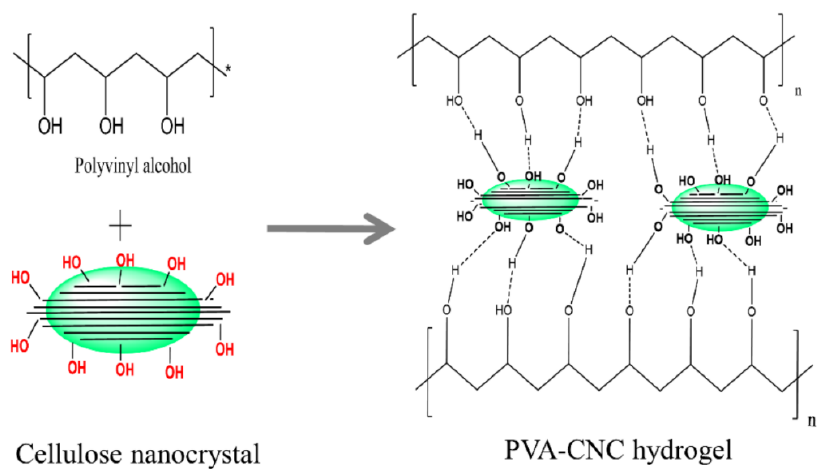
Figure 16. Formation of the PVA ‐ CNC hydrogel [58].